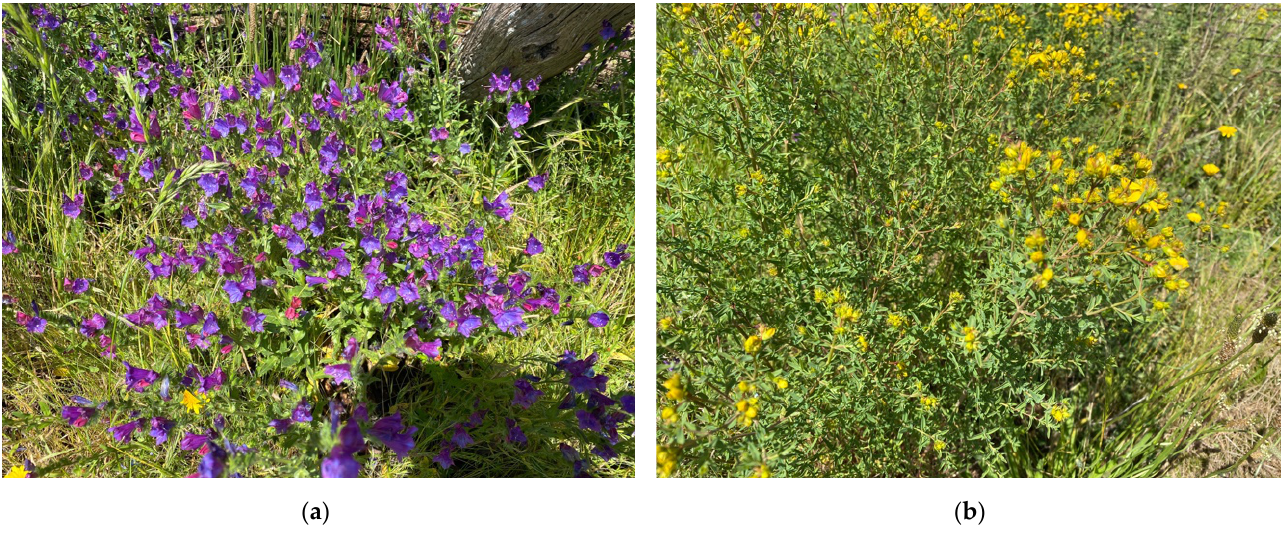
Figure 4. Examples of toxic plants ( a ) Patterson’s curse ( Echium plantagineum) is a cause of pyrrolizidine alkalosis; ( b ) St John’s Wort ( Hypericum perforatum) is a cause of photosensitisation. Images A. M. Harvey.